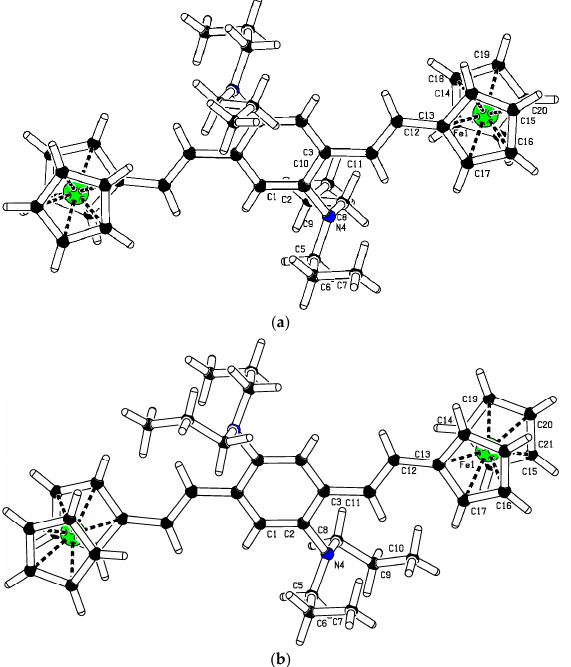
Figure 7. Molecular structure of 3 in the ecliptic ( a ) form with Fe as the inversion center of two Cp- rings, and staggered ( b ) conformer, with congruent Cp-rings. two Cp-rings, and staggered ( b ) conformer, with congruent